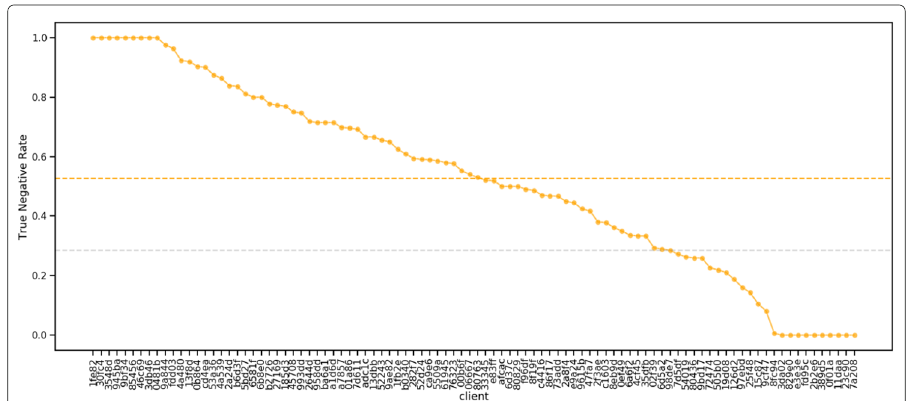
Fig. 16 True Negative Rate for each client in the Audit dataset. The True Negative Rate represents the number of fraudulent transactions correctly attributed by GraphSIF. The values on the x axis represent a client company from the Audit dataset. The grey dotted line represents the random baseline, while the blue dotted line represents the mean TNR over all clients